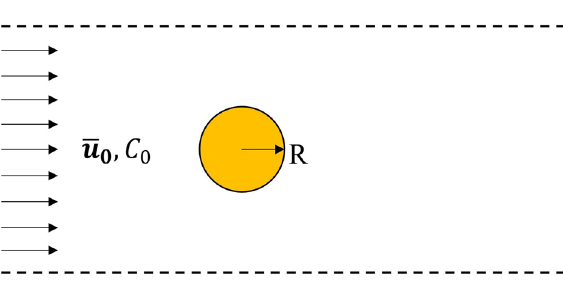
Figure 4. Schematics of validation case setup for both mpFoam and ALE